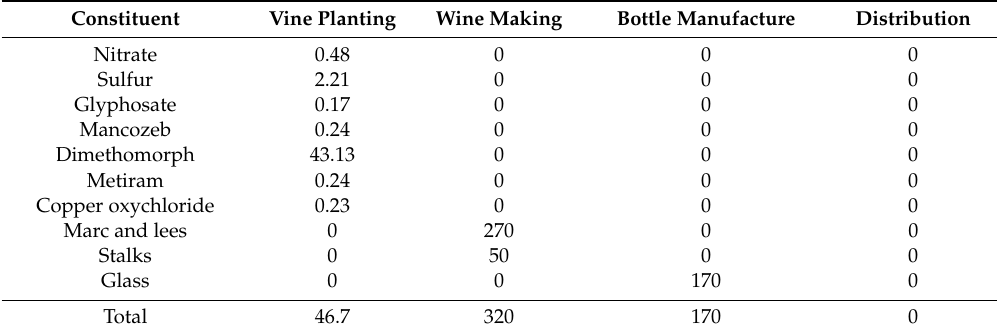
Table 3. Data inventory for solid waste disposal (g) for various stages of wine making per functional unit *.